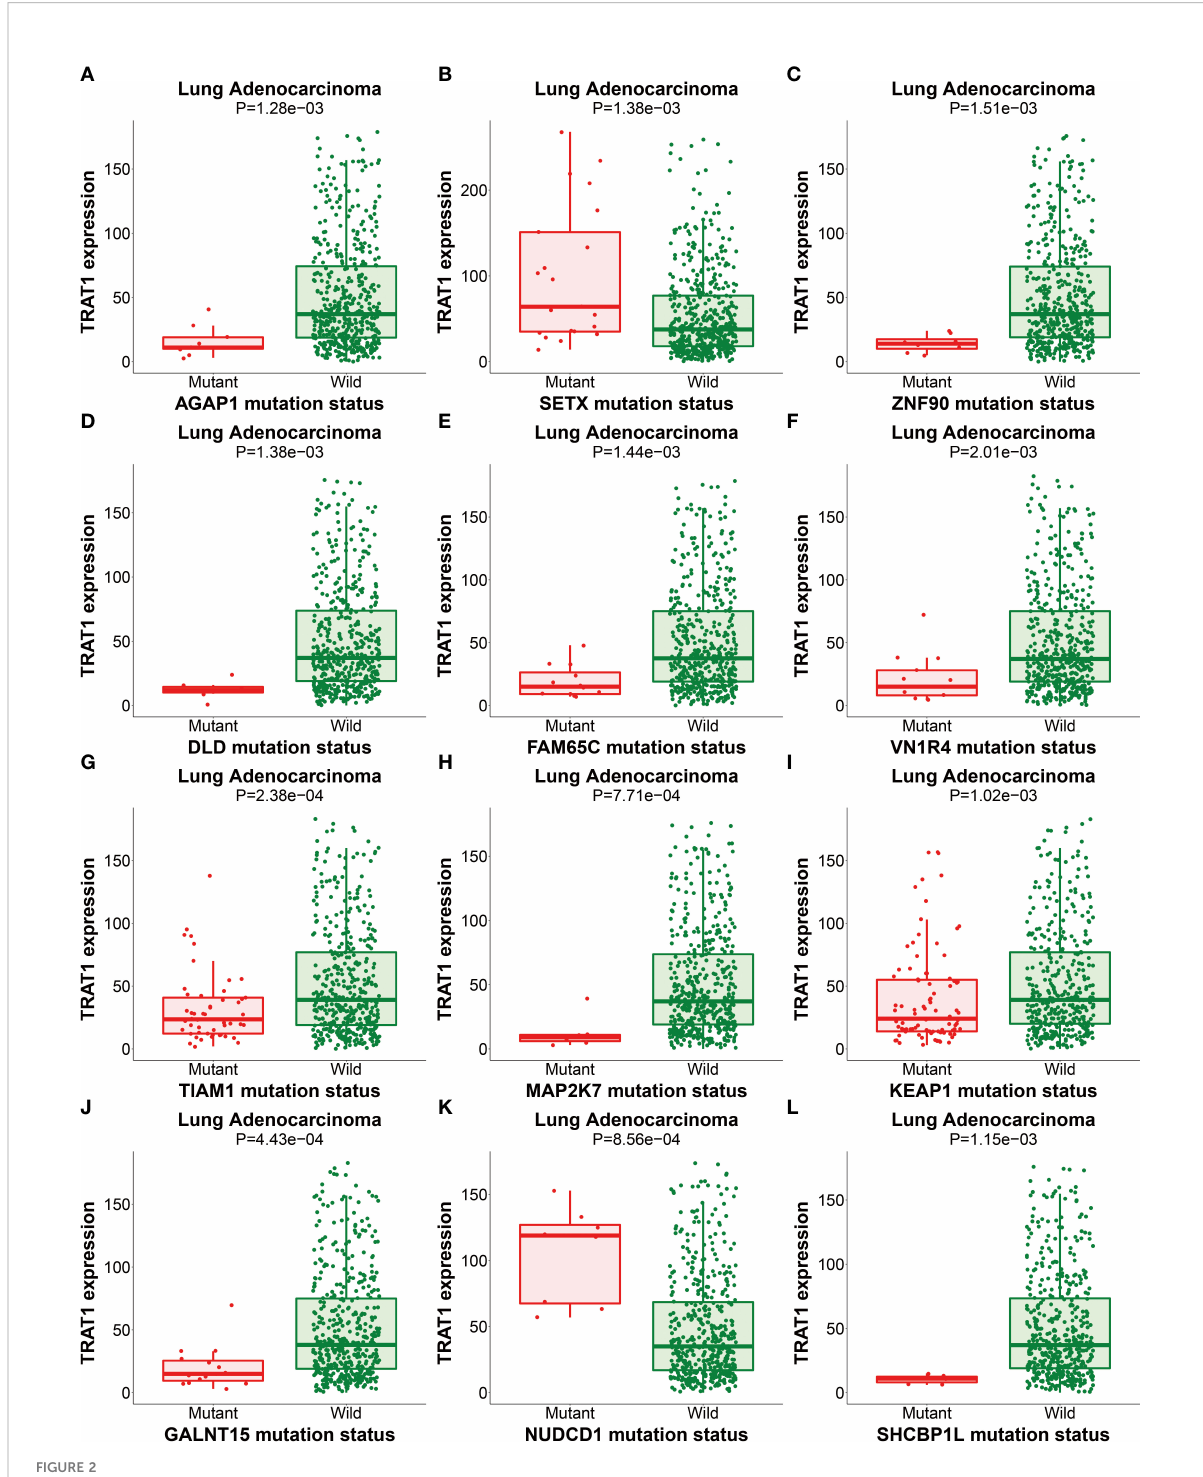
FIGURE 2 The expression of TRAT1 in LAC mutation sites. (A) AGAP1 ; (B) SETX ; (C) ZNF90 ; (D) DLD ; (E) FAM65C ; (F) VN1R4 ; (G) TIAM1 ; (H) MAP2K7 ; (I) KEAP1 ; (J) GALNT15 ; (K) NUDCD1 ; (L) SHCBP1 . LAC, lung